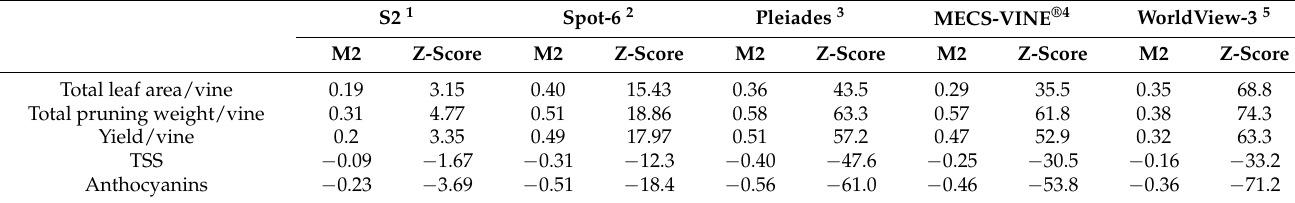
Table 7. Moran 2(M2), quantitative comparison between different platforms and ground data using bivariate Moran Index. M2 was calculated using ground data as X values and NDVI as